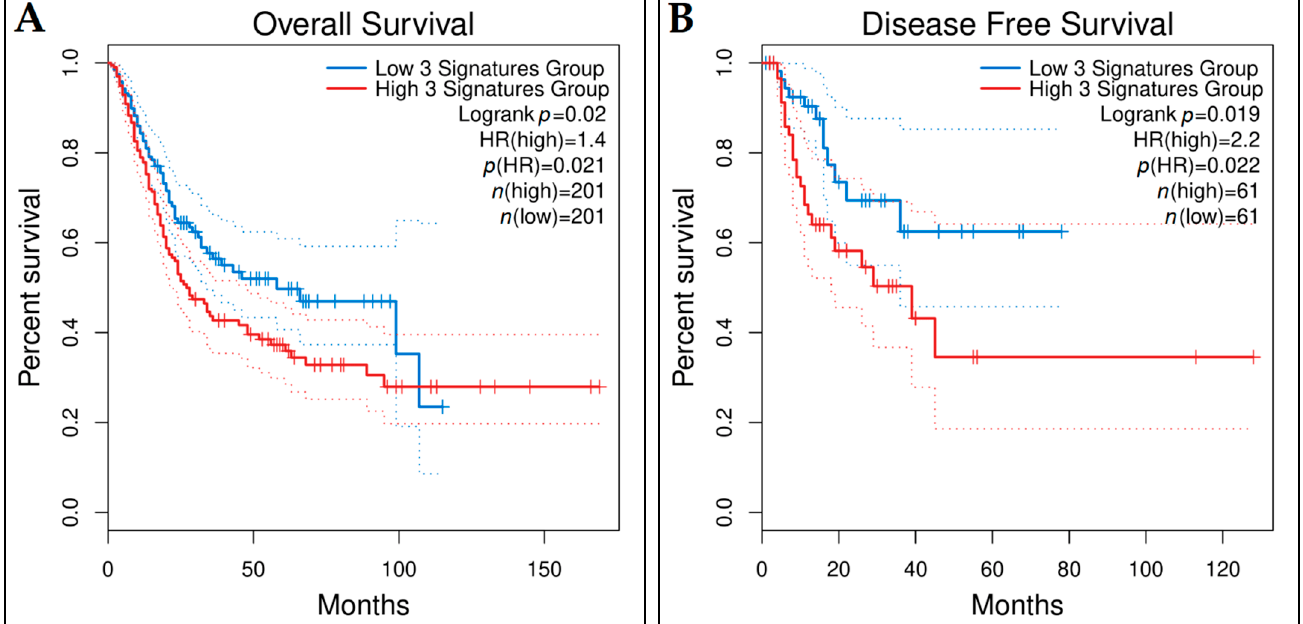
Figure 17. Kaplan–Meier survival plots of the three-gene prognostic signature, generated using the GEPIA2 platform. Red and blue lines indicate the high- and low-risk patient groups, respectively. Patients were grouped according to ( A ) median cut-off value for overall survival and ( B ) a custom cut-off high and low value of 85% and 15%, respectively, for disease-free survival.